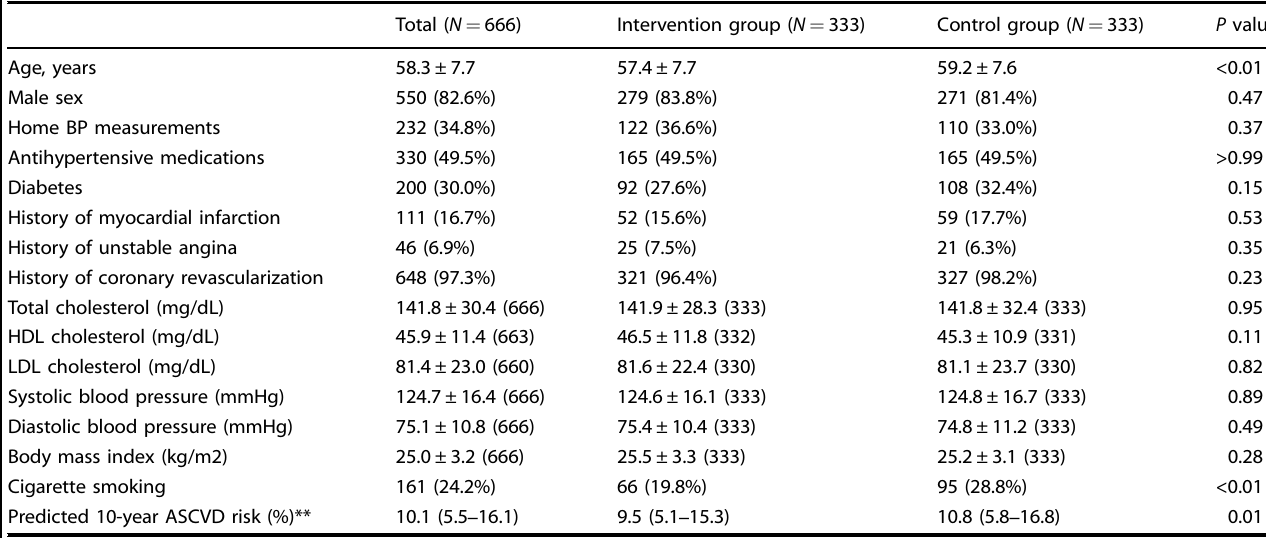
Table 1. Baseline features of included